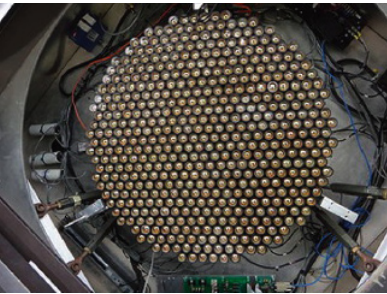
Figure 2. Photograph of one of the VERITAS cameras showing the new hQE PMTs (July 2012).